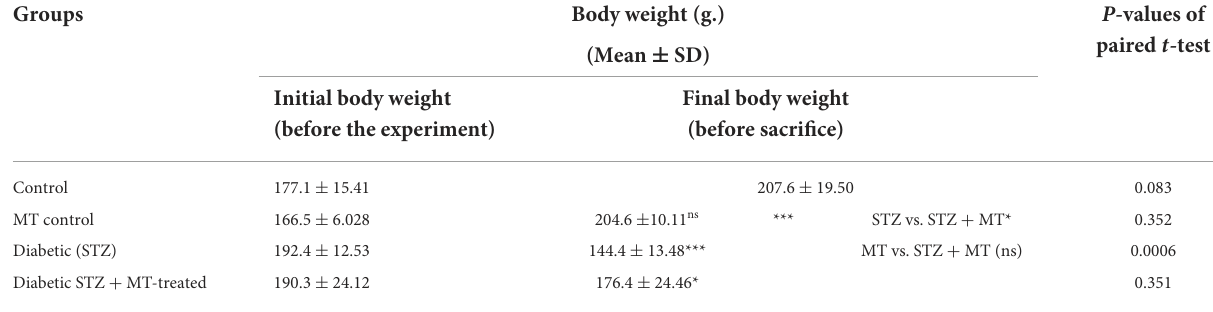
TABLE 1 Comparison of body weights in experimental groups in the STZ DM model. Groups